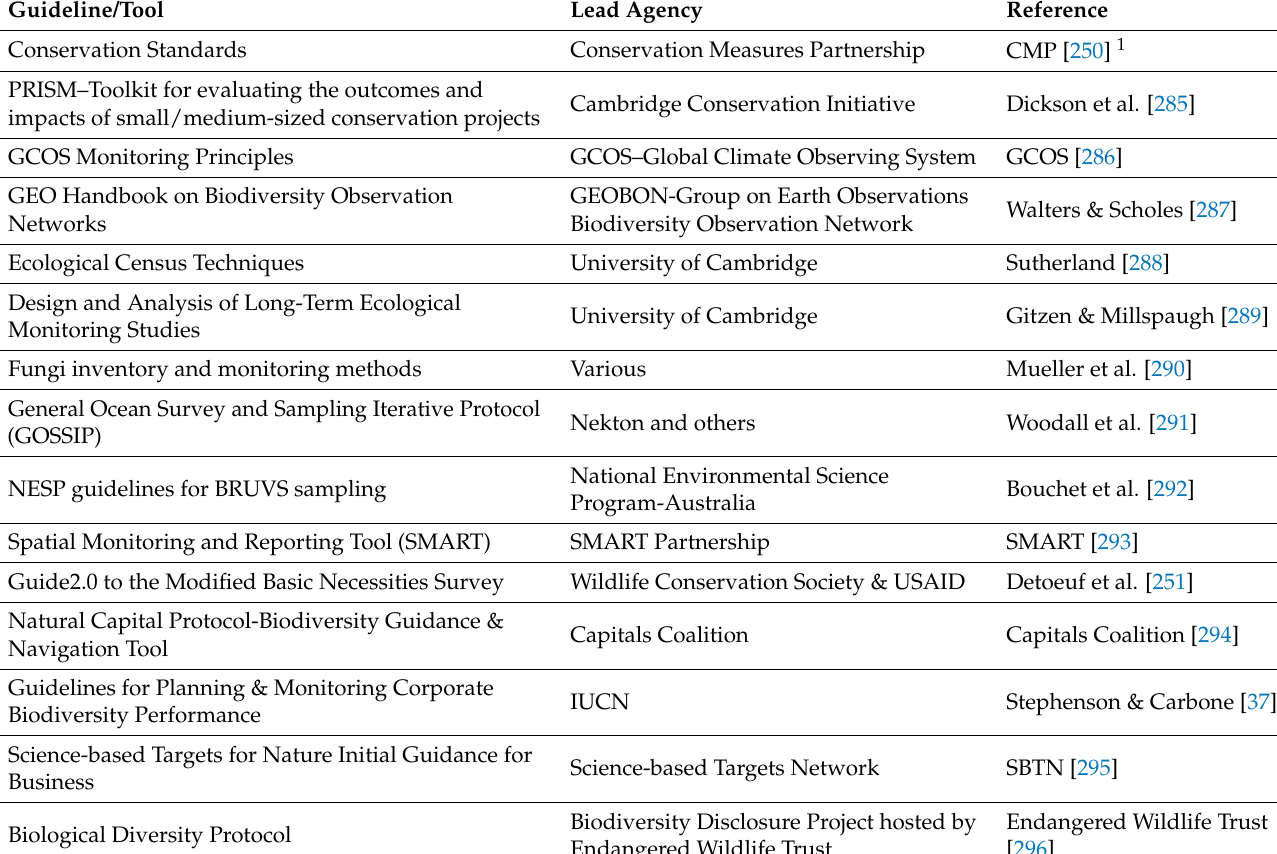
Table 1. Some examples of standards, guidelines and tools that, if rolled out at scale, could help improve biodiversity monitoring across stakeholder groups in different